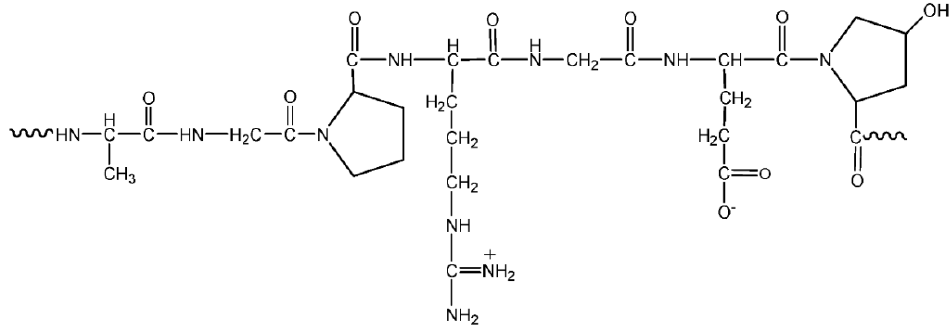
Figure 11. Representative unit of gelatin.